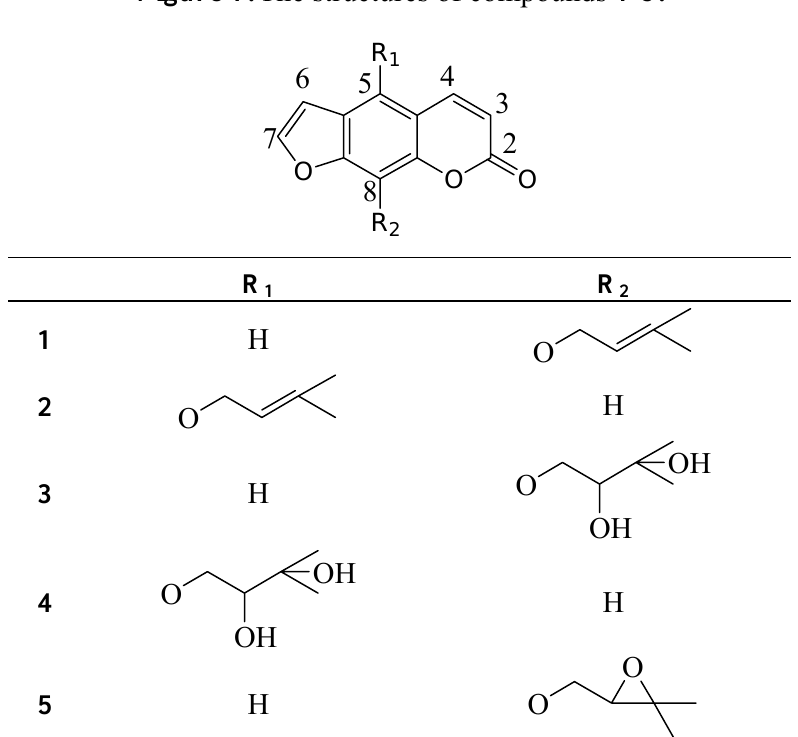
Figure 1. The structures of compounds 1 -